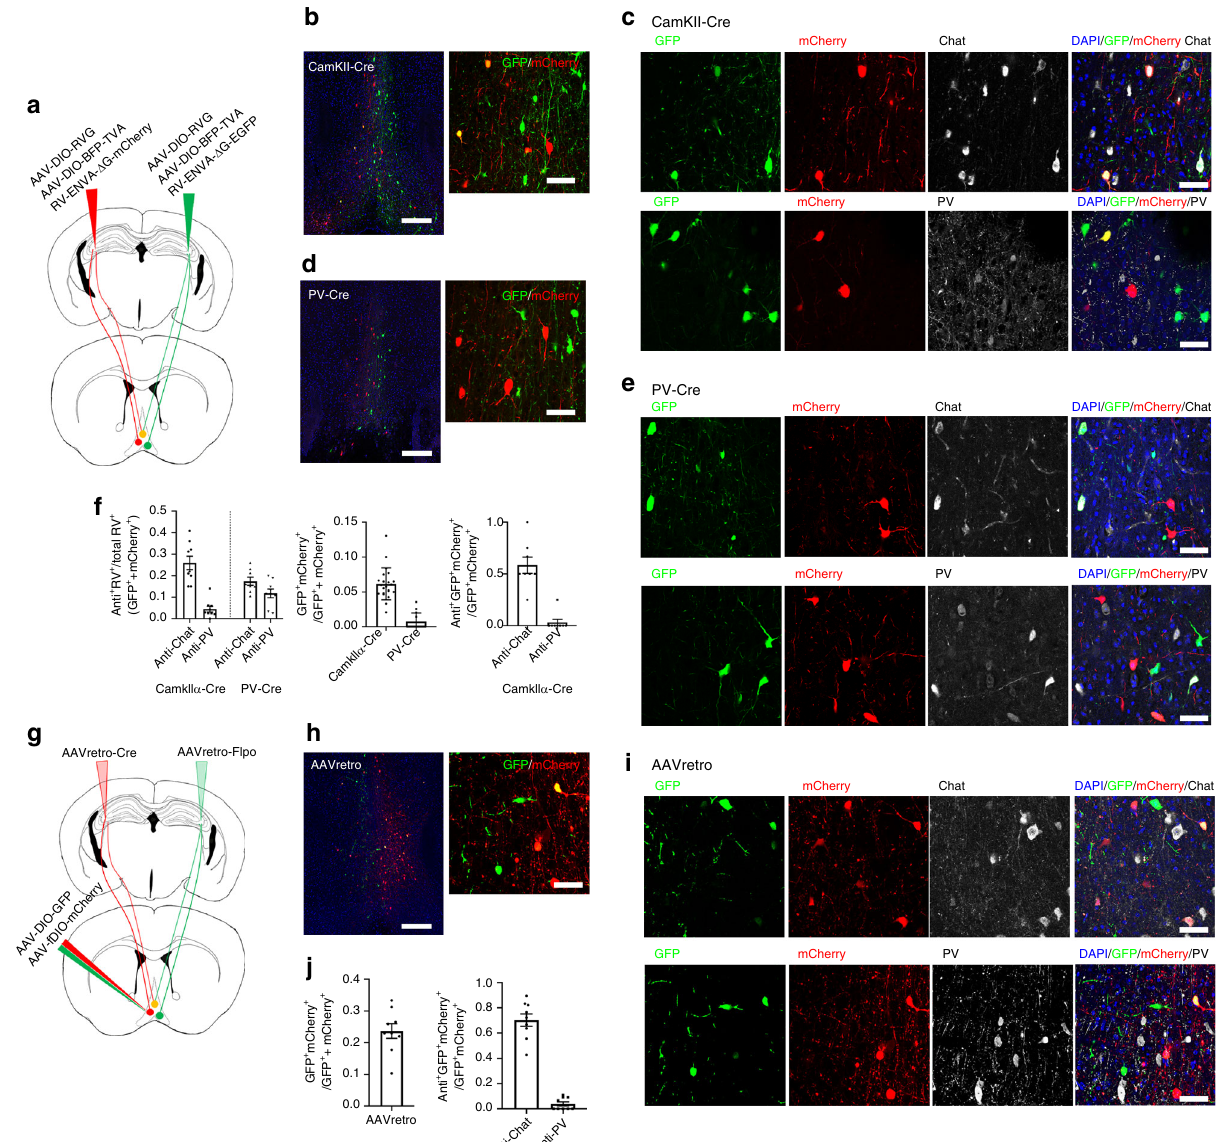
Fig. 5 MS PV neurons form monosynaptic connections with unilateral CA3. a Schematic representation of monosynaptic rabies retrograde tracing from bilateral CA3 pyramidal neurons in CamKII α -Cre mice or PV neurons in PV-Cre mice. b , c Confocal images of coronal sections showing RV input neurons (GFP + or mCherry + ) in MS from the tracing brains of CamKII α -Cre mice were co-labeled with cholinergic (white, up) or PV (white, bottom) neurons. Scale bar: left is 200 μ m; right is 50 μ m. d , e Confocal images of coronal sections showing RV input neurons (GFP + or mCherry + ) in MS from the tracing brains of PV-Cre mice were co-labeled with cholinergic (white + , up) or PV (white, bottom) neurons; Scale bar: left is 200 μ m, right is 50 μ m. f Left: quanti fi cation of percentage of all RV labeling cells (GFP + or mCherry + ) that were cholinergic neurons or PV neurons in CamkII α -Cre ( n = 9 images from three mice) or PV-Cre mice ( n = 9 images from three mice). Middle: quanti fi cation of percentage of all RV labeling cells were double-positive neurons (GFP + mCherry + ) in CamkII α -Cre or PV-Cre mice. Right: quanti fi cation of percentage of double-positive cells that were cholinergic neurons or PV neurons in CamkII α -Cre mice. g Schematic of AAV-retro tracing system. Injection of AAVretro-Flpo and AAVretro-Cre in bilateral CA3 respectively and a mixture of AAV-DIO-GFP and AAV-fDIO-tdTomato in MS. h , i Confocal images of coronal sections showing Cre-positive neurons (GFP + ) and Flpo-positive neurons (mCherry + ) in MS were co-labeled with cholinergic (white, up) or PV (white, bottom) neurons. Scale bar: left is 200 μ m, right is 50 μ m. j Left: quanti fi cation of the percentage of AAVretro labeling cells that were double-positive neurons (GFP + mCherry + ). Right: quanti fi cation of the percentage of double AAVretro labeling cells (GFP + and mCherry + ) that were cholinergic neurons or PV neurons in WT mice ( n = 9 images from three mice). Data are presented as mean ± SEM ( f , g ). Source data are provided as a Source Data fi